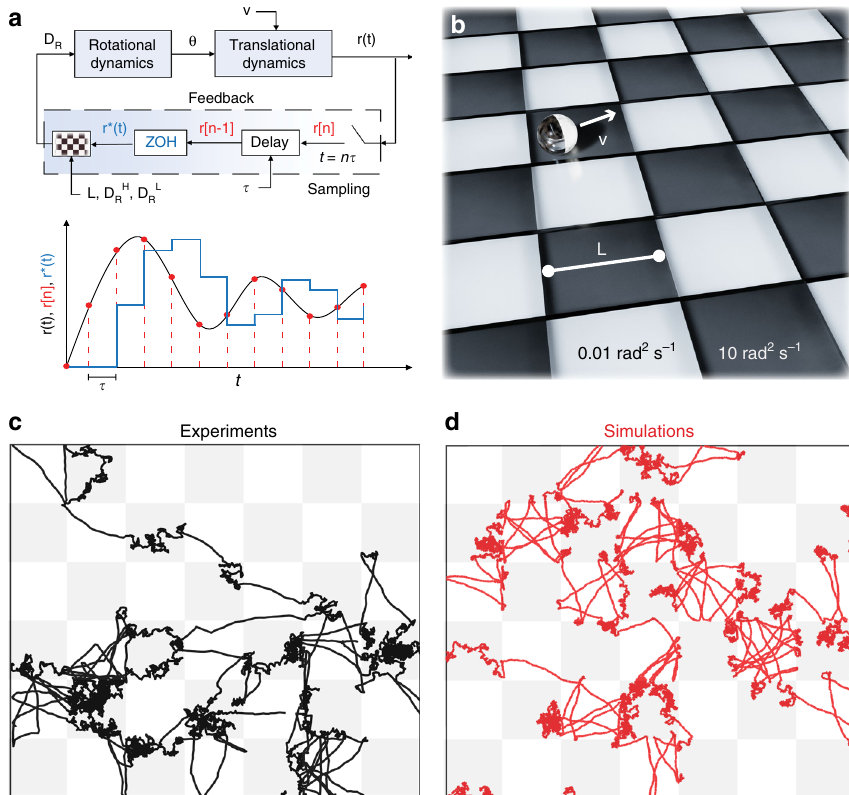
Fig. 2 Position-dependent rotational dynamics: sampling a checkerboard pattern with a sensorial delay. a (top) Block diagram illustrating the feedback loop enforced both in experiments and simulations to achieve space-time modulations of the rotational dynamics. The feedback function that couples D R with the particle ’ s position r(t) consists of four blocks in series: sampling, delay, zero-order hold (ZOH), and D R = f ( r ). a (bottom) Schematic representation of how r(t) is sampled at discrete time points t = n τ (corresponding to r[n]) and reconstructed via a ZOH model (r * (t)) after a delay of τ , i.e., using the position r[n-1] as input. b Schematic of an ABP moving over a checkerboard pattern of rotational diffusivity. c – d Side-by-side comparison of experimental (black) and simulated (red) trajectories of ABPs with D R varying according to the checkerboard pattern. ( v = 3.5 μ m s − 1 , L = 32 μ m, D H